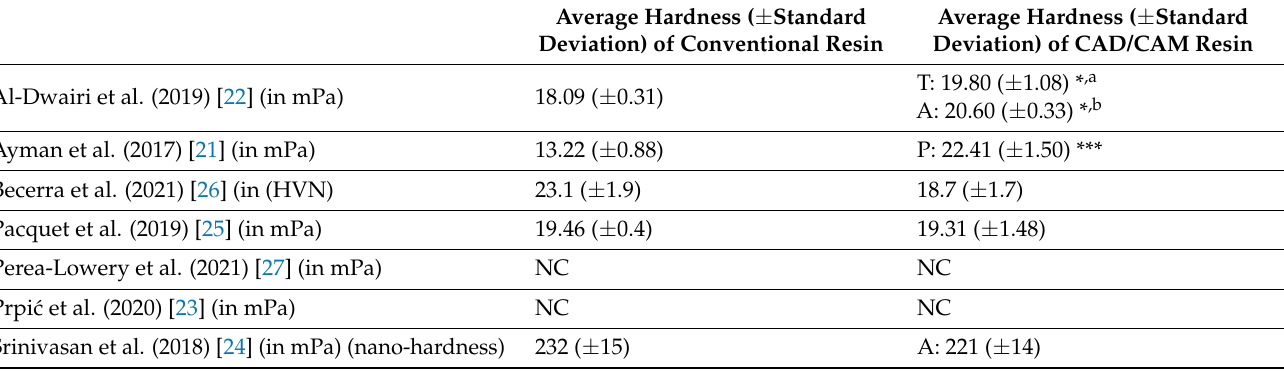
Table 2. Hardness test